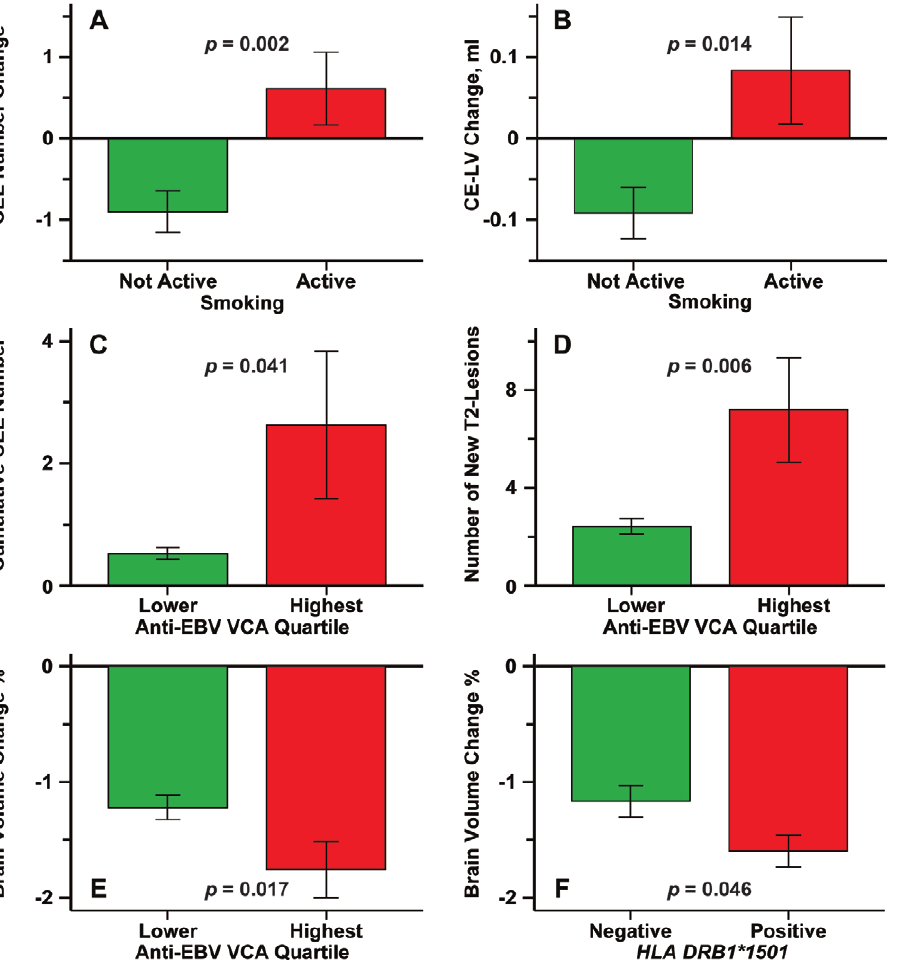
Figure 2. Dependence of change in individual MRI lesion-related variables over 2-years on the specific genetic or environmental factors. Figures 2A and 2B show the dependence of change in CEL number and change in CE-LV, respectively, on smoking status. Figures 2C shows the dependence of number of new and newly enlarging T2-lesions on anti-EBV VCA highest quartile status. Figure 2D shows the dependence of number of new T2-lesions on anti-EBV VCA highest quartile status. The bars represent mean values and the error bars are standard errors. The red colors denote the positive group and the green bars the negative group. The corresponding covariate p -values from regression are also shown.